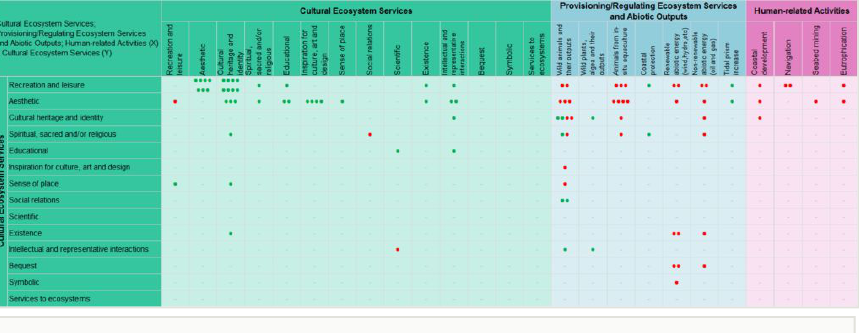
Synergies and trade-o ff s of marine and coastal CES. The fi gure shows synergies and trade-o ff s within CES, between CES and provisioning/regulating ecosystem services and abiotic outputs, and between CES and human-related activities. Abiotic outputs refer to those ecosystem elements that provide bene fi ts to humans but are not generated by biotic processes (e.g., minerals, wind, waves). One green dot represents a synergy , and one red dot a trade-o ff , as identi fi ed in the